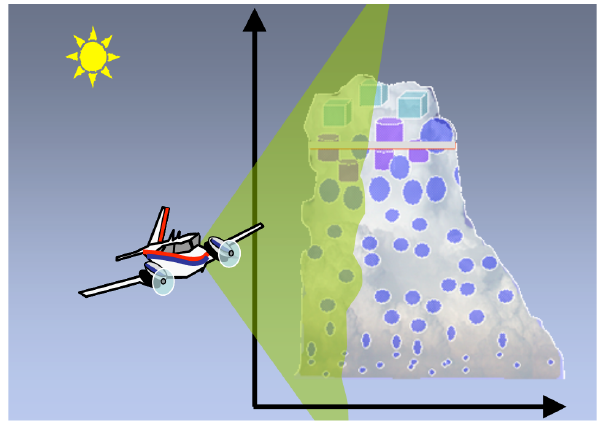
Fig. 2. Cloud side observations from low altitude aircraft. Fig. 3. Schematic representation of cloud side measurements per-